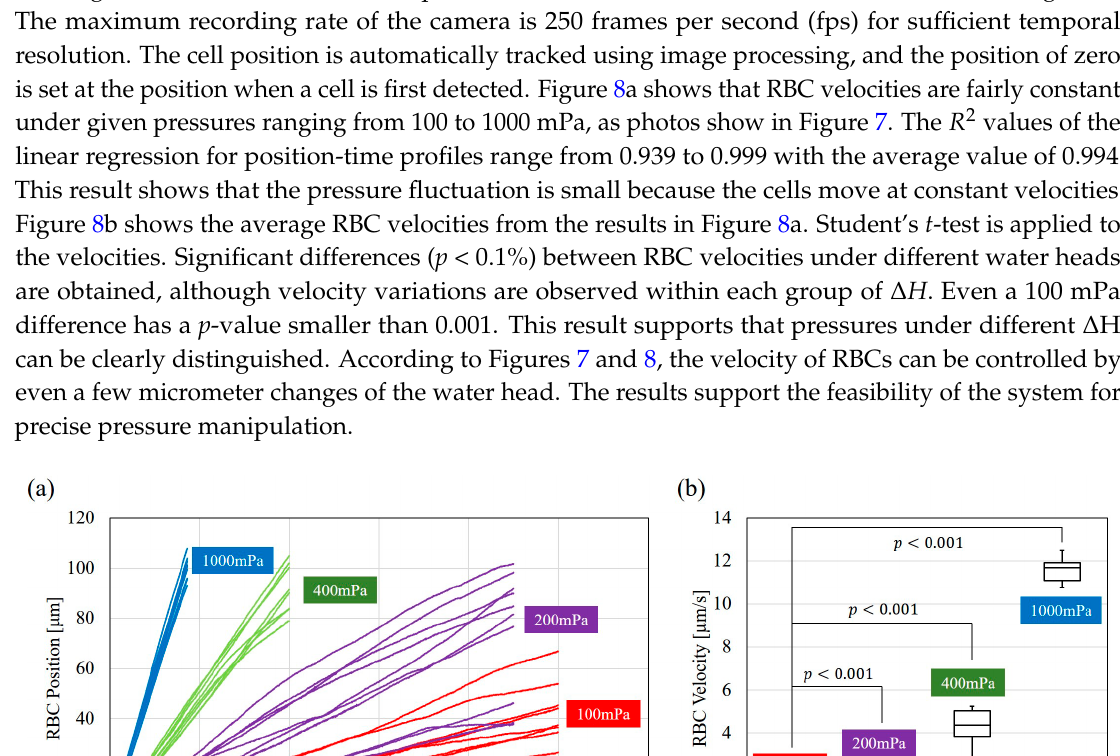
∆ H : ( a ) ∆ H “ 10 µ m; . Figure 7. Series of photos of cell position with respect to time under various Δ𝐻𝐻